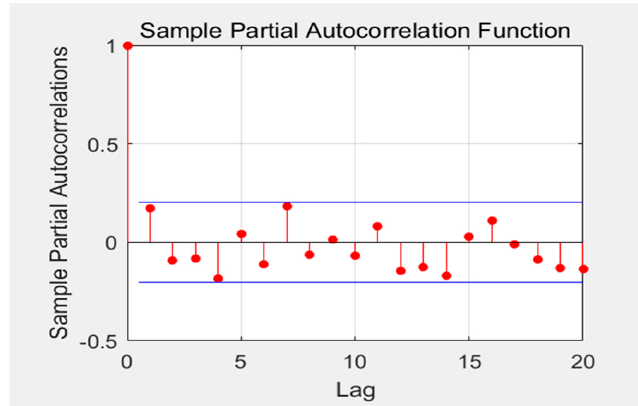
Figure 12. PACF function.